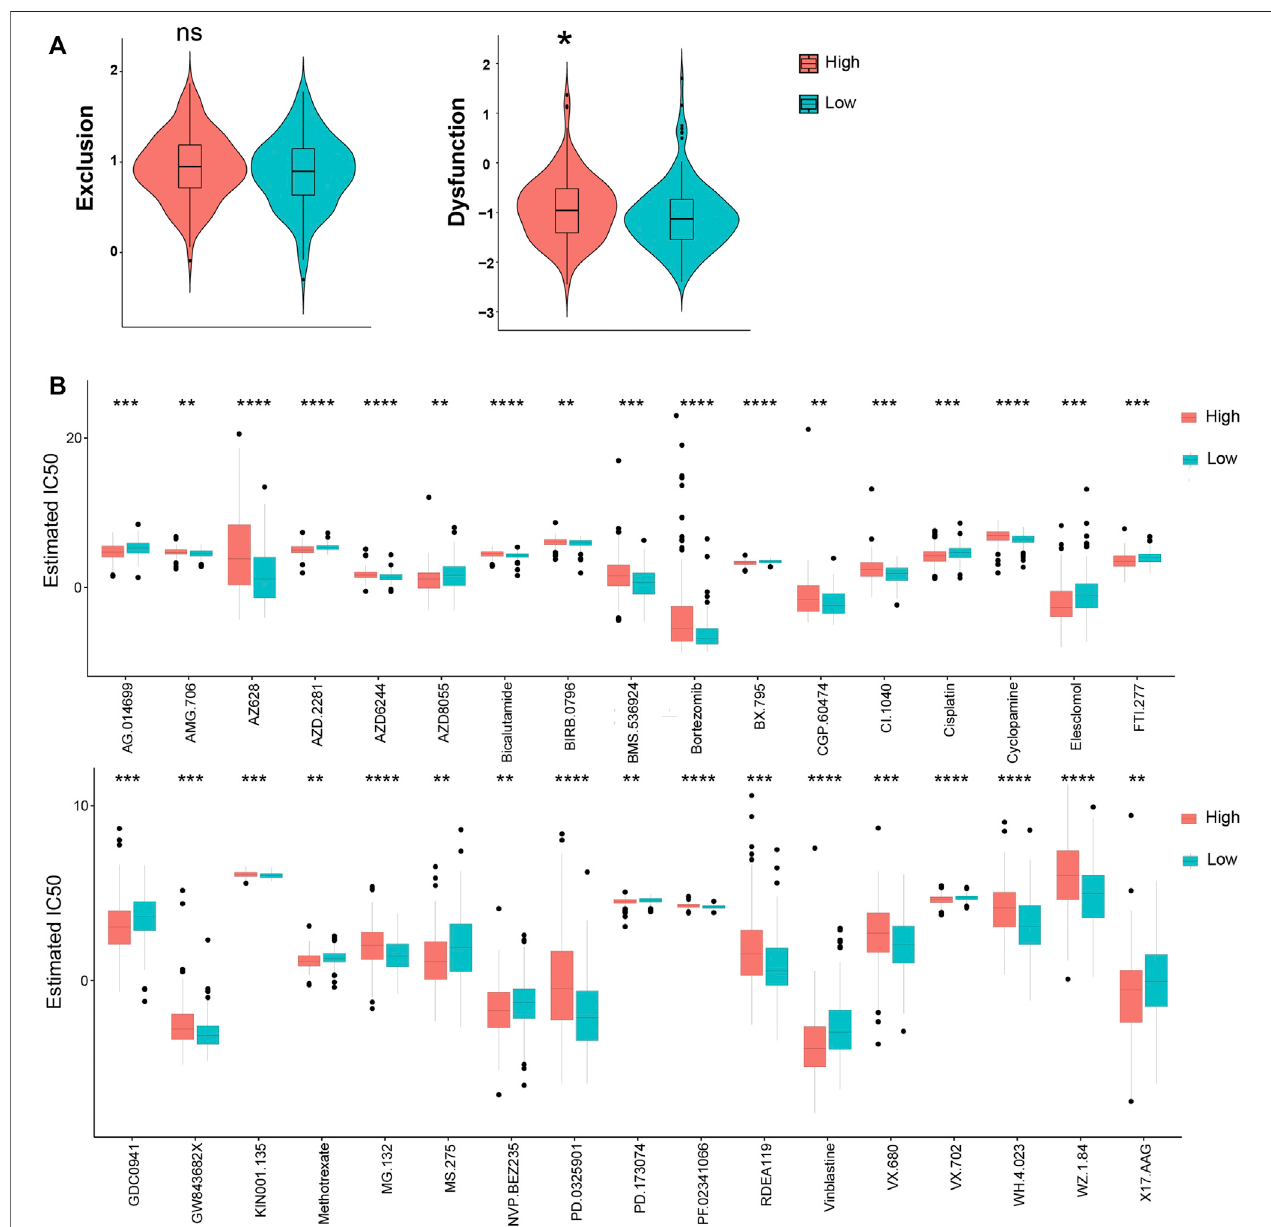
FIGURE 7 | The prognostic value of KRGPS in patients receiving immune and chemical therapy. (A) Exclusion and dysfunction scores of samples in KRGPS subgroups. (B) Chemotherapeutic responses of high- and low-KRGPS patients. *adj. p < 0.05, **adj. p < 0.01, ***adj. p < 0.001, ****adj. p < 0.0001.